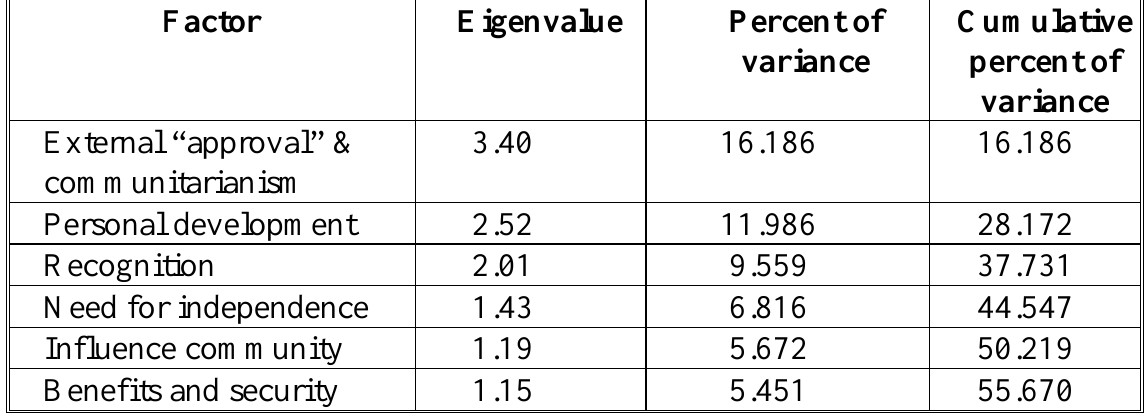
Cumulative variance percent of